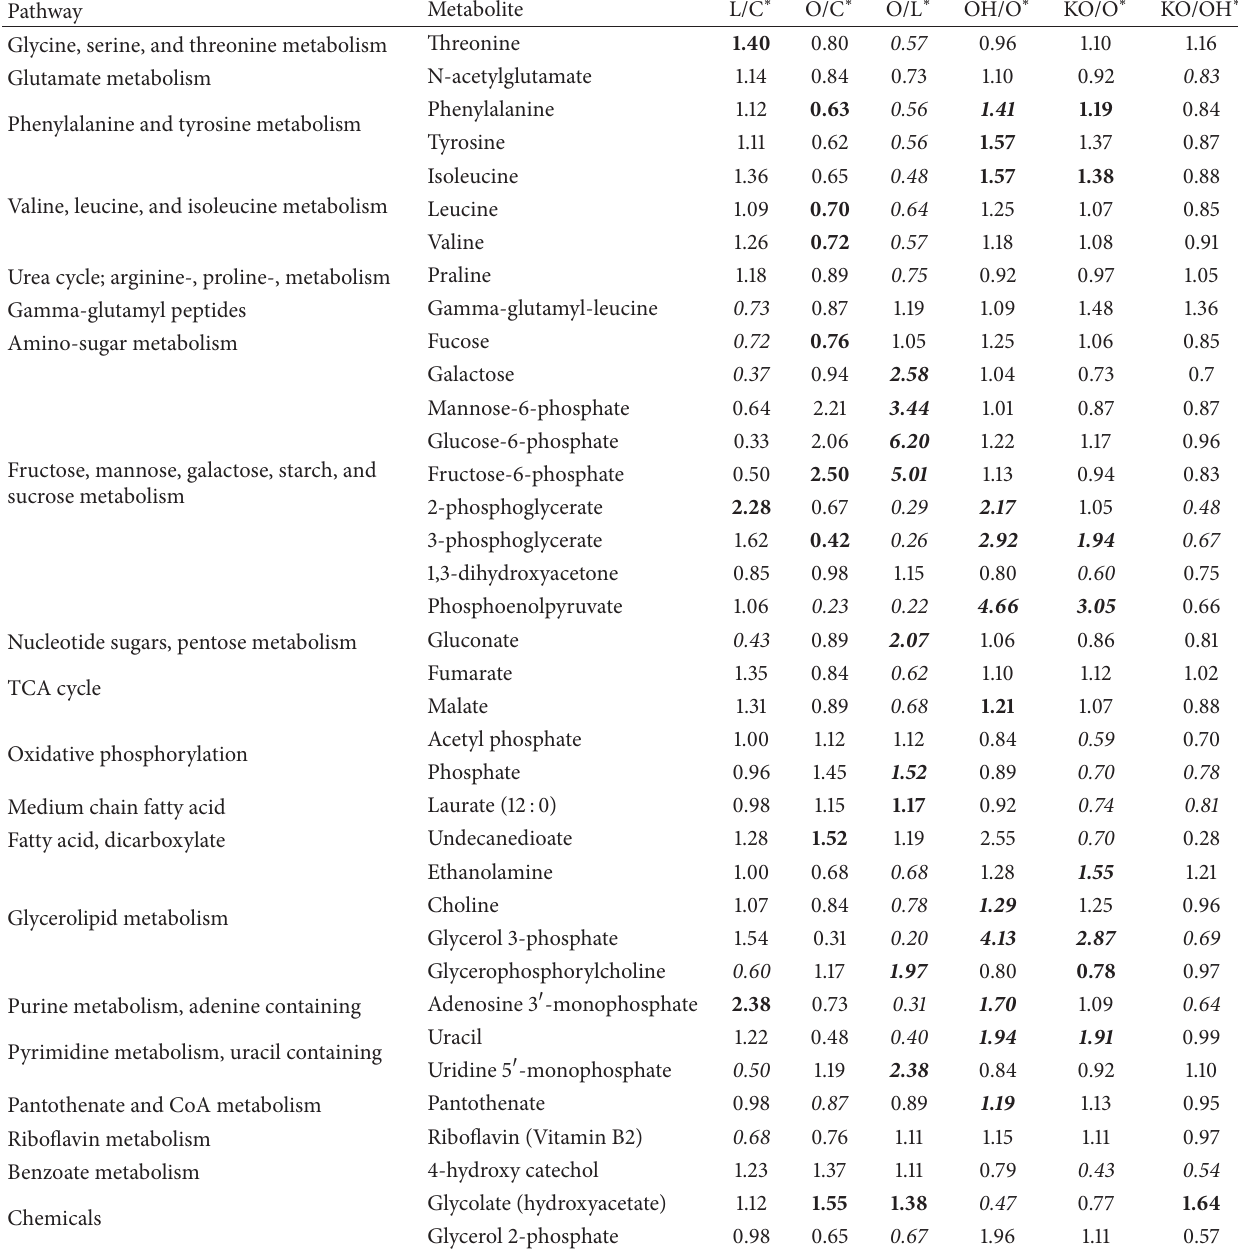
Table 1: Heat map of metabolites showing statistically significant differences between